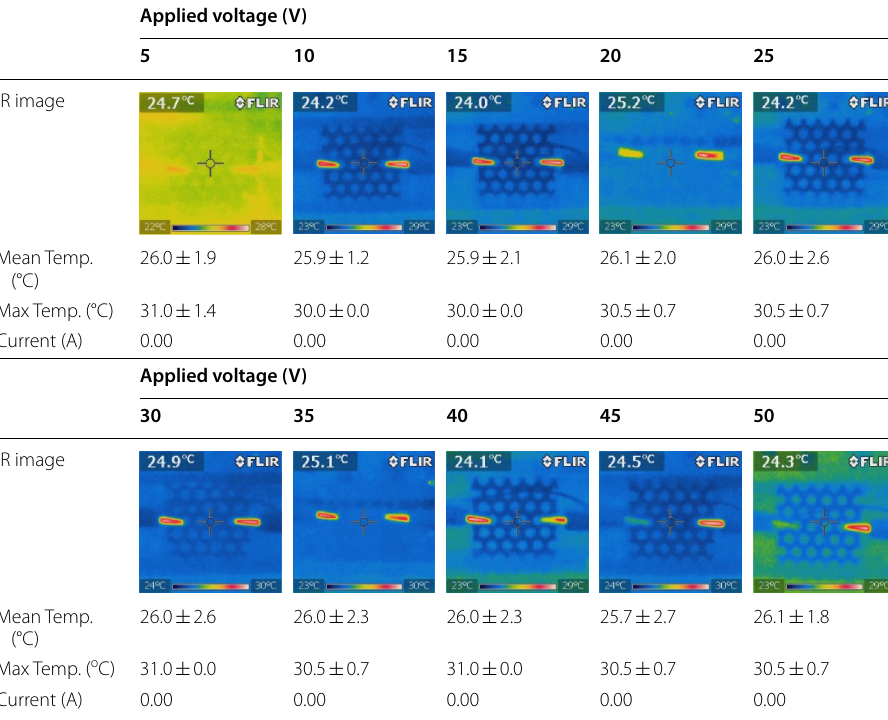
Table 6 IR images of CD PLA 3D printed honeycomb samples Applied voltage